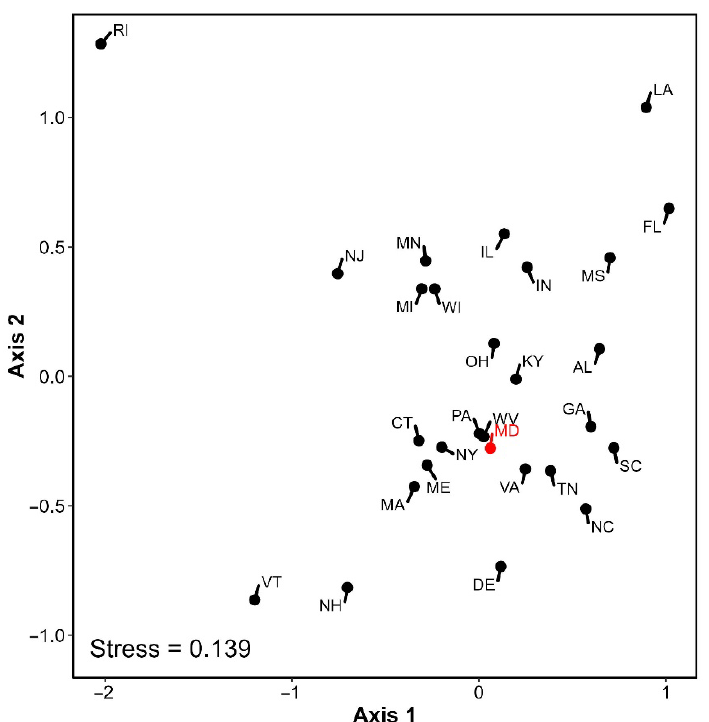
Figure 4. Non-metric Multi-Dimensional Scaling plot of regional stonefly assemblages for eastern United States of America (USA) states. Black circles represent USA states and are labeled with abbreviations of USA postal codes. Maryland (MD) is highlighted with a red circle and red text.